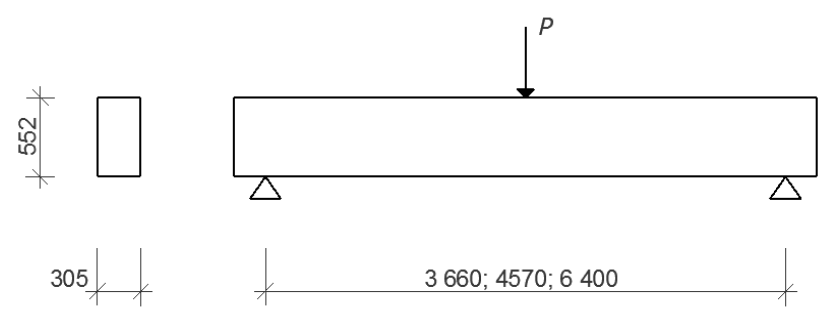
Figure 1: Scheme of the